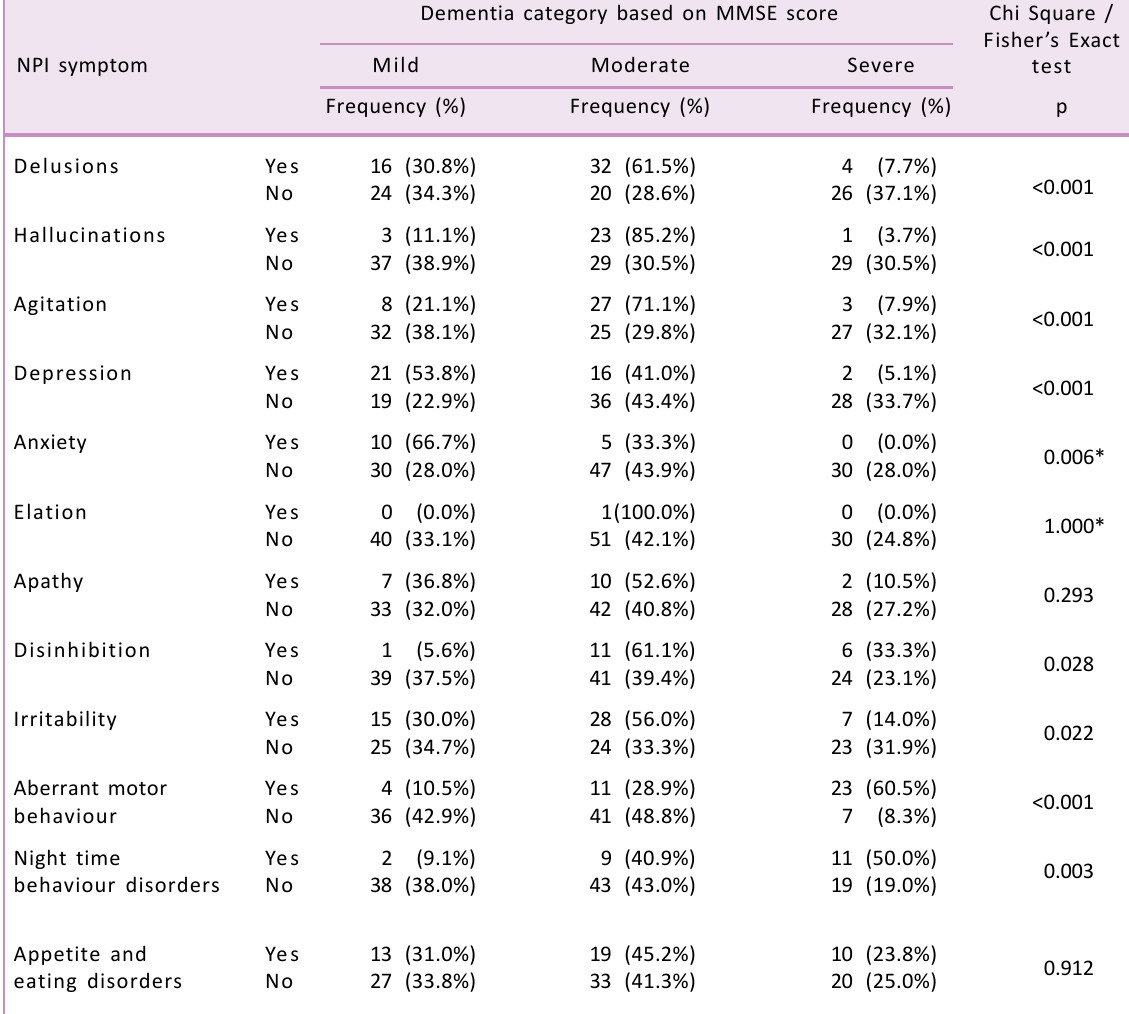
Table 1. Association between the presence of neuropsychiatric symptoms and severity of